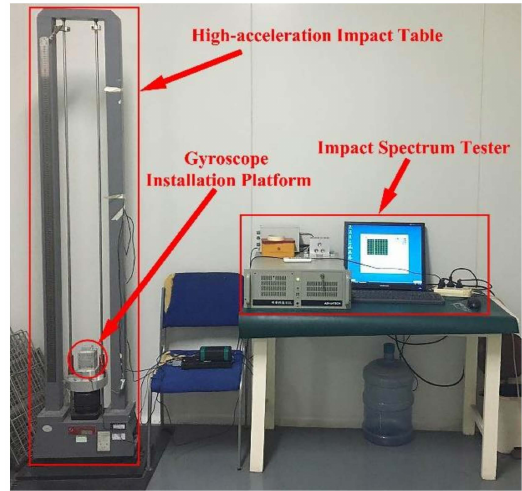
Figure 19. High-acceleration shock test table.